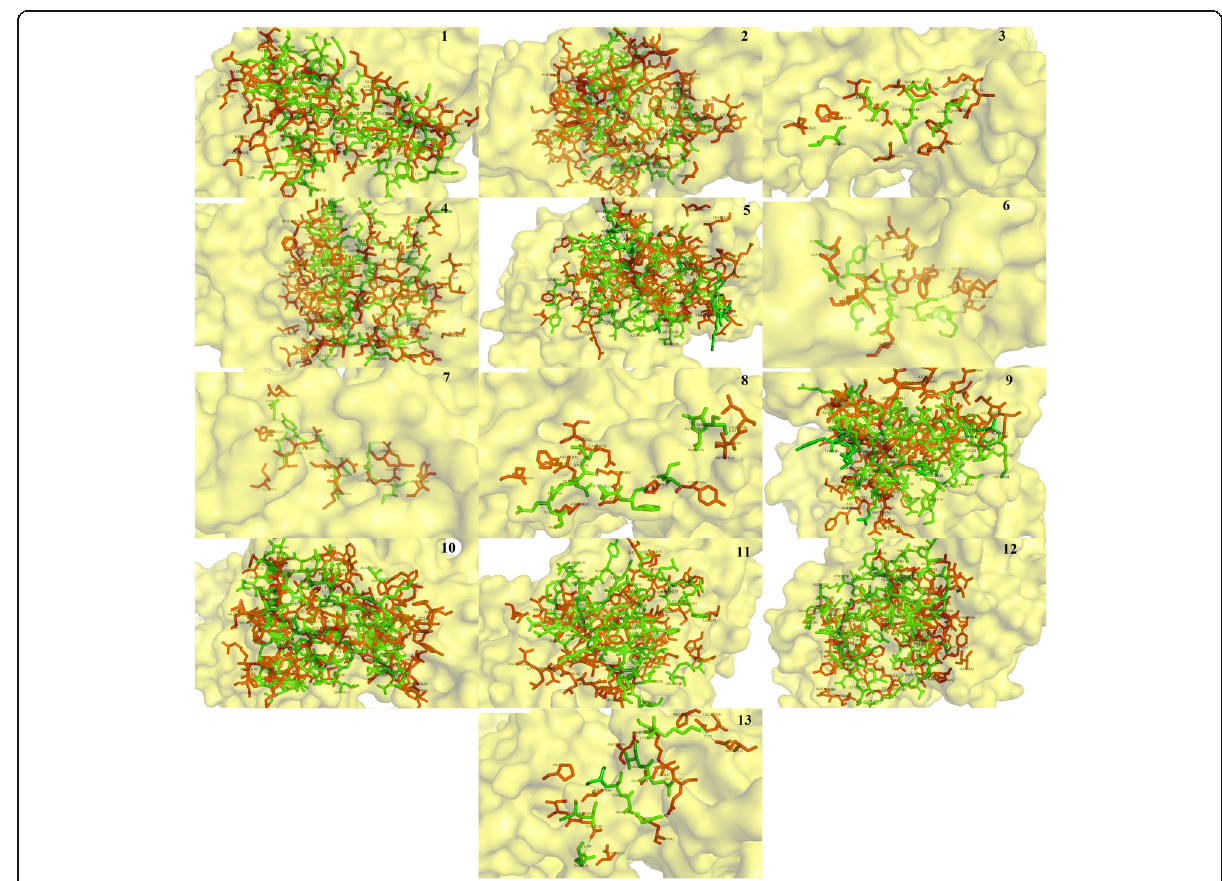
Fig. 4 Three-dimensional binding representation of NMDAR (humans) with each conantokin ligand: ( 1 ) conantokin Br, ( 2 ) conantokin E, ( 3 ) conantokin G, ( 4 ) conantokin L, ( 5 ) conantokin P, ( 6 ) conantokin Pr1, ( 7 ) conantokin Pr2, ( 8 ) conantokin Pr3, ( 9 ) conantokin R, ( 10 ) conantokin R1B, ( 11 ) conantokin R1C, ( 12 ) conantokin R1A, ( 13 ) conantokin T. Receptor chain (red), ligand chain (green), ligand-receptor complex surface